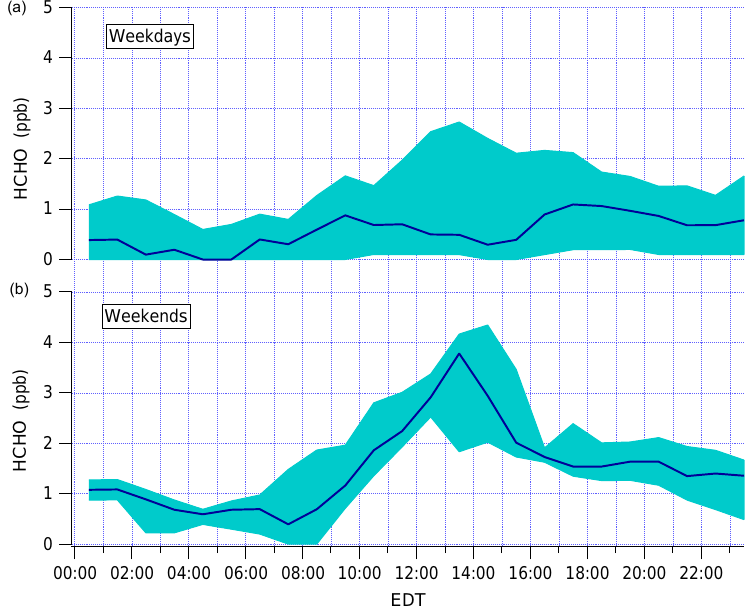
Figure 11. Average diurnal cycles of HCHO on weekdays (a) and on weekends (b) for the 16-day study period. Solid green lines are medians, and the shaded areas are the interquartile